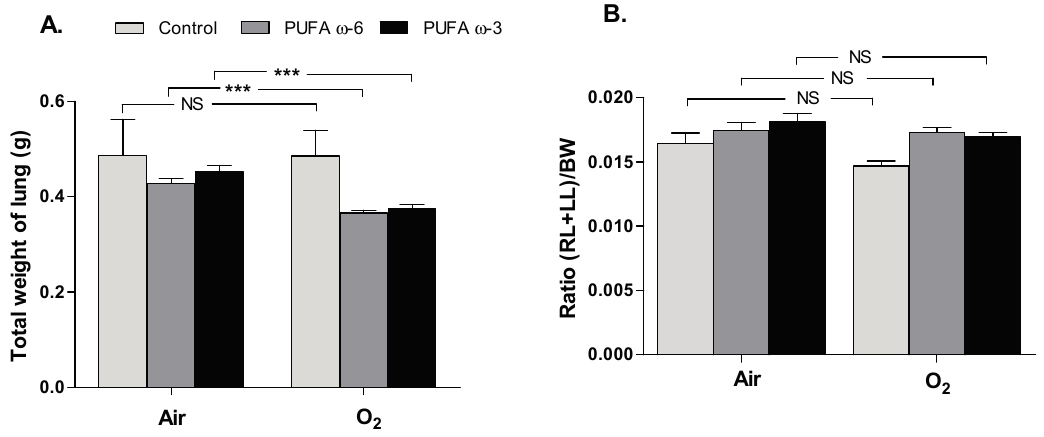
Figure 2. Lung morphometry, comparing the weight of both lungs ( A ) expressed as the ratio right and left lungs /body weights (RL + LL)/BW ( B ) in newborn rats exposed to hyperoxia or not, and according to the type of supplementation. Values are expressed as mean ± SEM ( n = 30 in PUFA ω -6/air, in PUFA ω -3/air, in PUFA ω -6/O 2 and in PUFA ω -3/O 2 , and n = 10 in control/air and in control/O 2 ). *** p < 0.001; NS: not significant. RL: right lung; LL: left lung; BW: body